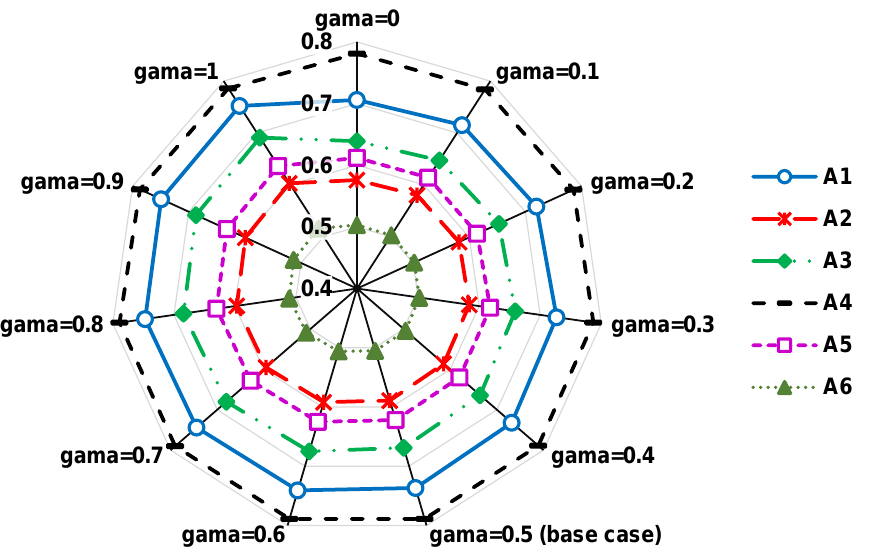
Figure 4. The sensitivity analysis to changes in the trade-off parameter γ .